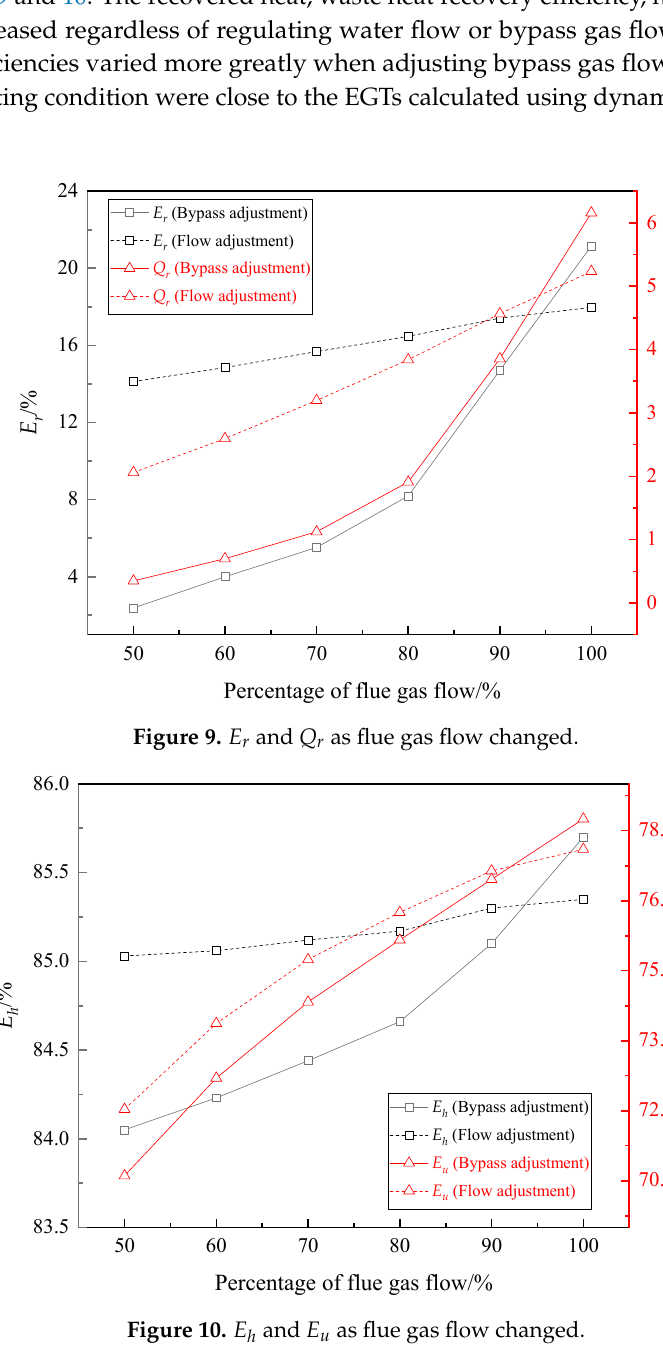
Figure 8. Adjustment curve as flue gas flow changed.